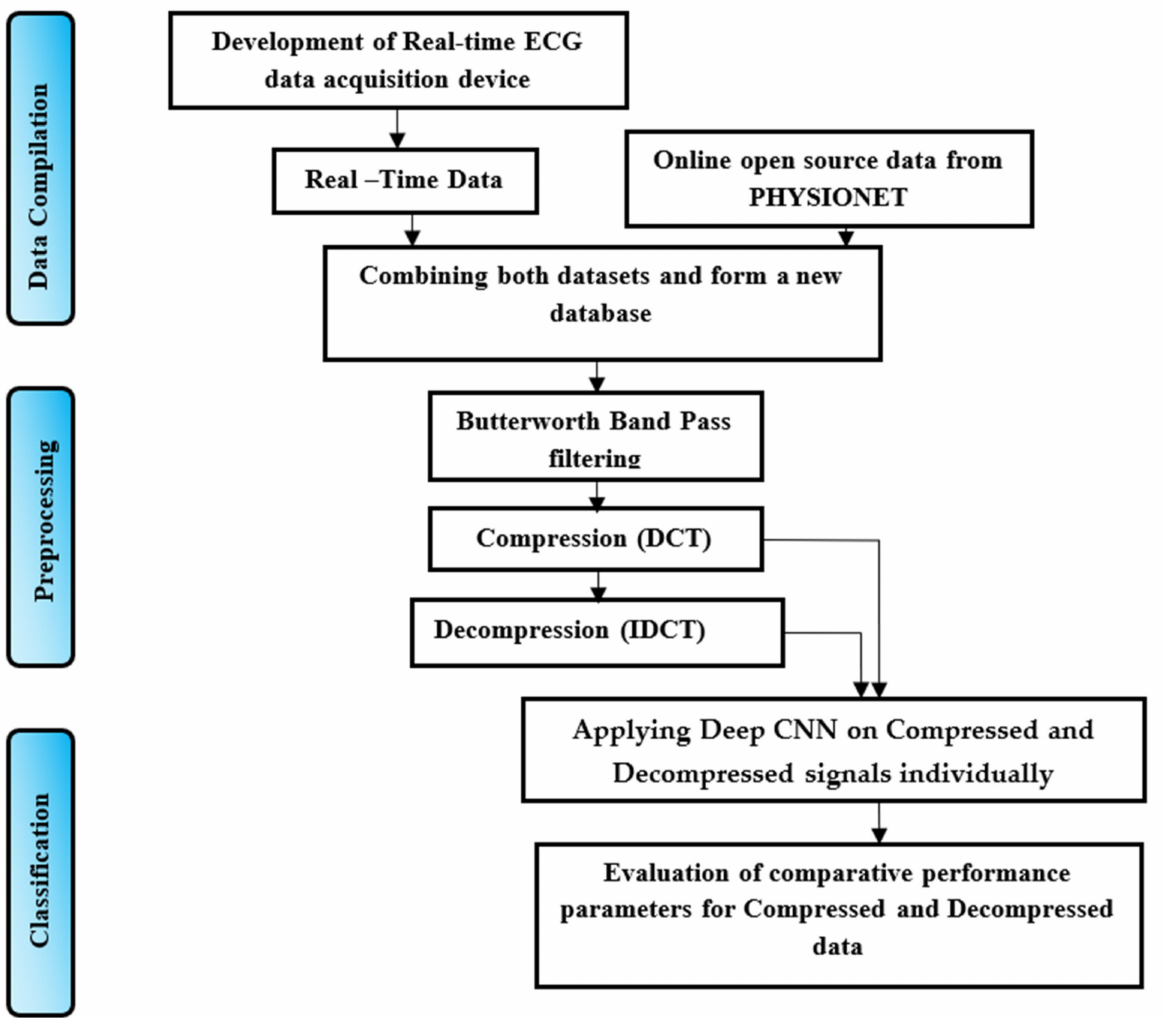
Figure 2. Processing paradigm for